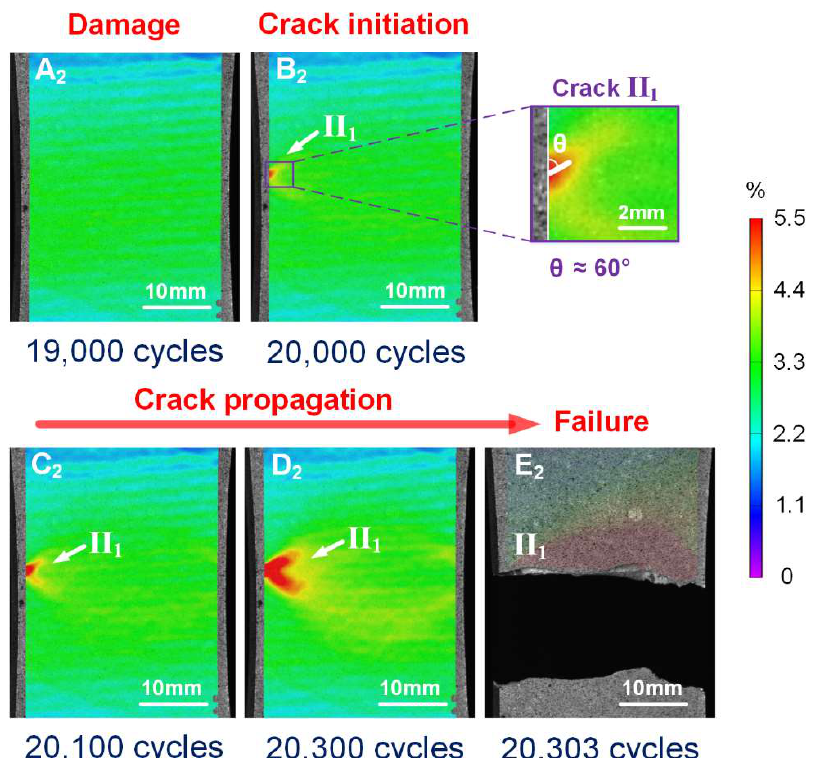
Figure 8. Measured contour-plot distribution of evolution of maximum tensile strain, facilitating visualization of damage, crack initiation and propagation for corrosion time of 48 h.